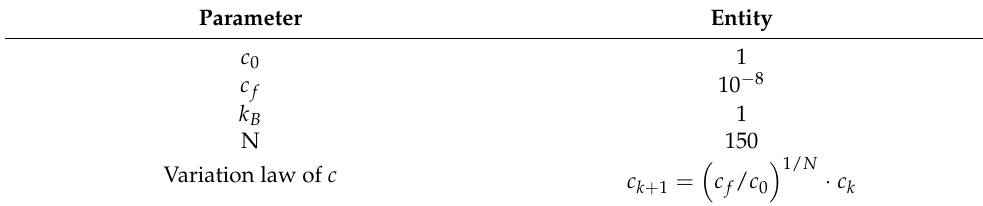
Table 1. Parameters used in the optimization